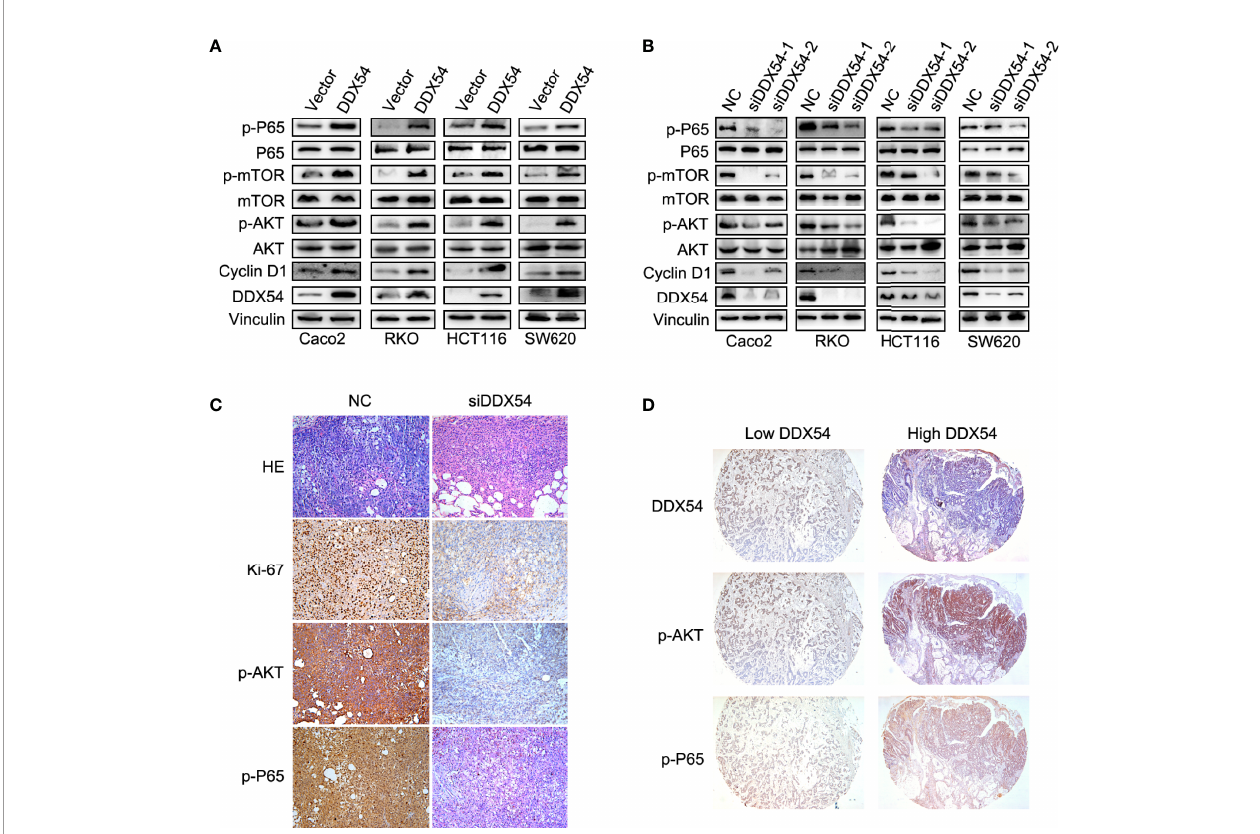
FIGURE 5 | DDX54 activated the NF- k b and AKT/mTOR pathway. (A) The enhanced DDX54 up-regulated the phosphorylation level of P65 and AKT in RKO, Caco2, SW620, and HCT116 cells. (B) The phosphorylation level of P65 and AKT was reduced by DDX54 inhibition with RNAi in RKO, Caco2, SW620, and HCT116 cells. (C) The Ki-67, p-P65, and p-AKT were examined in mice subcutaneous tumors with DDX54 knockdown. (D) The level of p-P65 and p-AKT in CRC patients with high DDX54 was higher than those with low